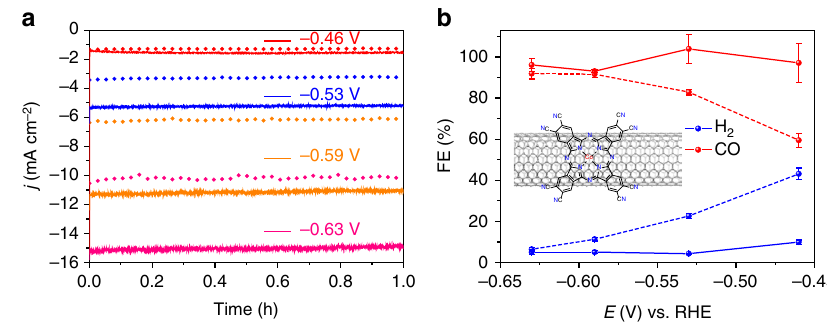
Figure 4 | Introduction of cyano groups to CoPc enhances catalytic performance. ( a ) Chronoamperograms and ( b ) Faradaic efficiencies of reduction products at different potentials for CoPc-CN/CNT (solid line) in comparison with CoPc/CNT (dotted line). Inset in ( b ) shows the molecular structure of CoPc-CN, which is anchored on CNT. The average values and error bars in b are based on six measurements during three reaction runs (two product analysis measurements were performed in each run). The error bars represent s.d. of six measurements. The data are all iR corrected.